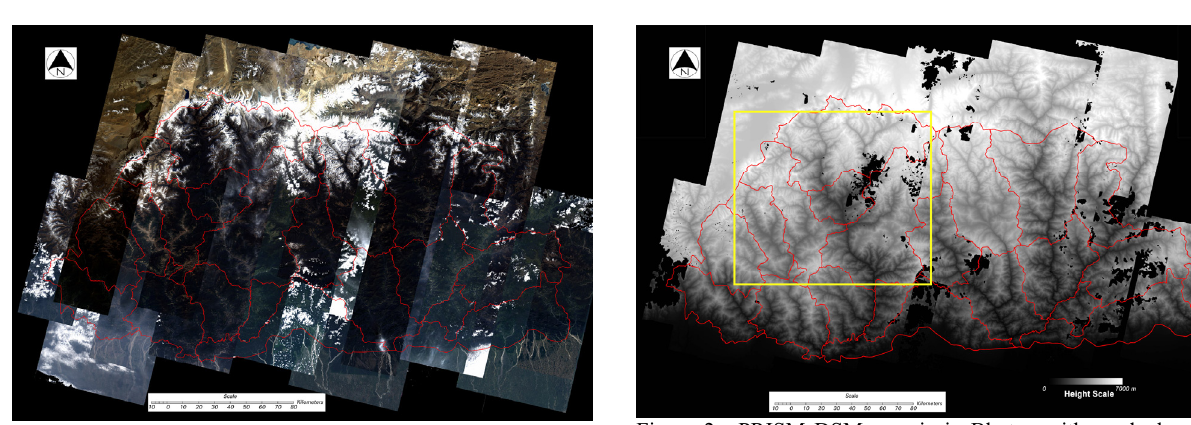
Figure 1. Pan-sharpened mosaic by PRISM and AVNIR-2, covering the entire country of Bhutan (R, G, B = Band 3, 2, 1). The red lines show national and local administration boundaries.